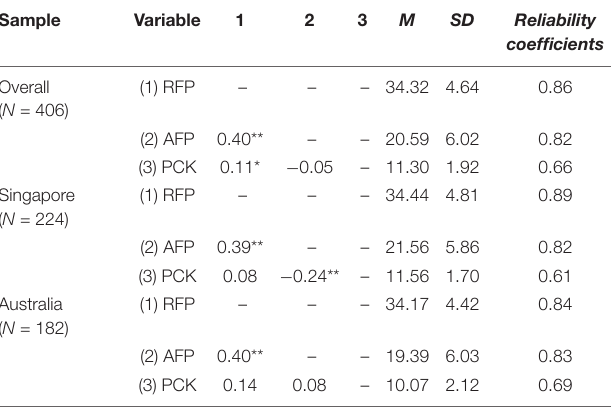
TABLE 3 | Intercorrelations, descriptives, and reliability coefficients of reciprocal filial piety, authoritarian filial piety, and palliative care knowledge in the overall, Singapore, and Australia